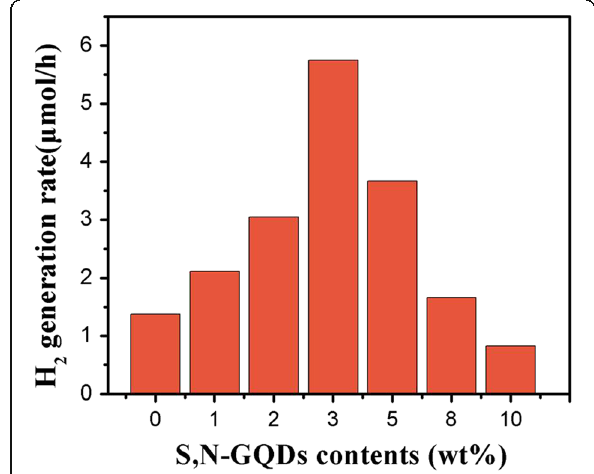
Fig. 6 Photocatalytic H 2 generation rates of pure P25 and S,N-GQD/P25 composites with different amounts of S,N-GQDs under UV – vis